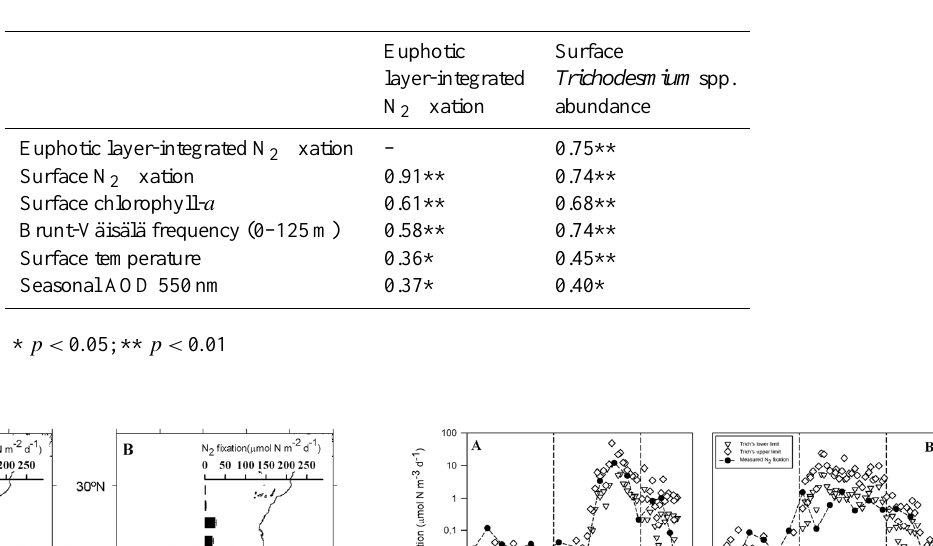
Table 2. Correlation coefficients (Pearson’s r ) between euphotic-layer integrated N 2 fixation and surface Trichodesmium spp. abundance and selected variables computed for all the stations sampled during the 2007 and 2008 cruises.